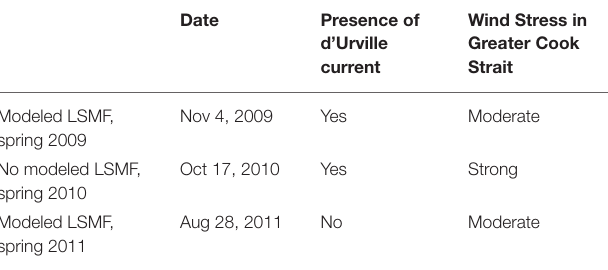
TABLE 3 | Three cases chosen from modeled results for analysis during presence and absence of modeled